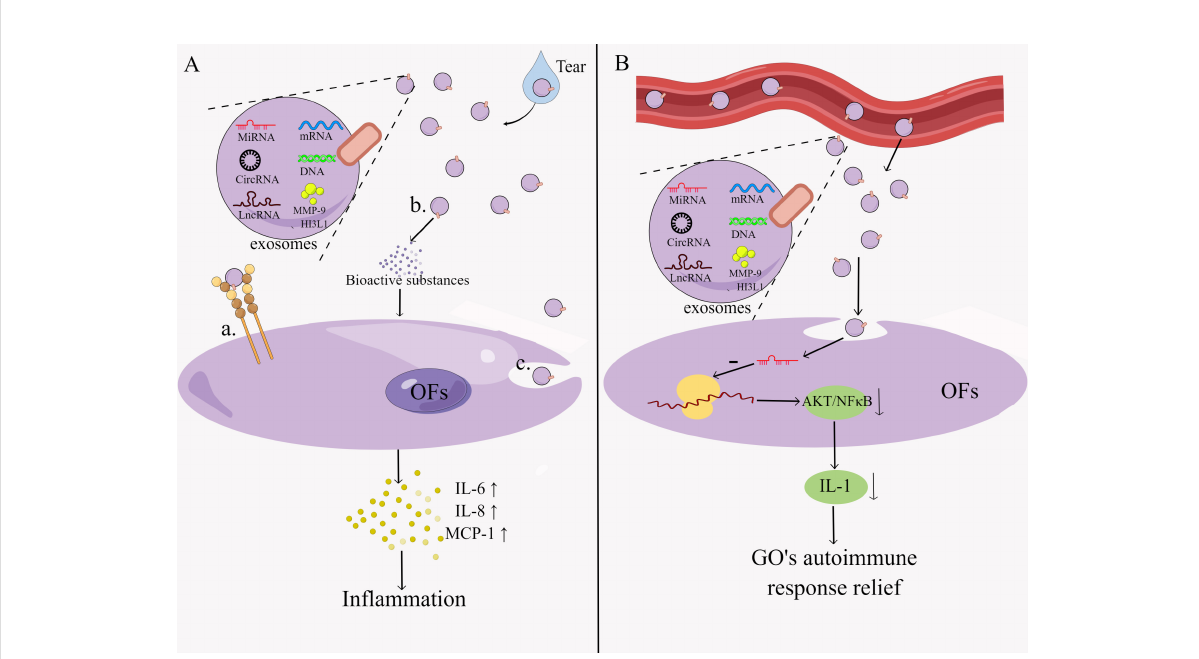
FIGURE 3 Pathogenesis of exosomes in GO.Exosomes regulate the immune response by two main mechanisms: (A) exosomes act directly on target cells thereby activating downstream signals. This process is characterized by: a. The direct action of surface signaling molecules. b. Extracellular release of bioactive substances. c. Intracellular regulation of signaling molecules during membrane fusion. (B) Exosomes mediate regulation of immune responses through exosomal miRNA. By Figdraw (www. fi